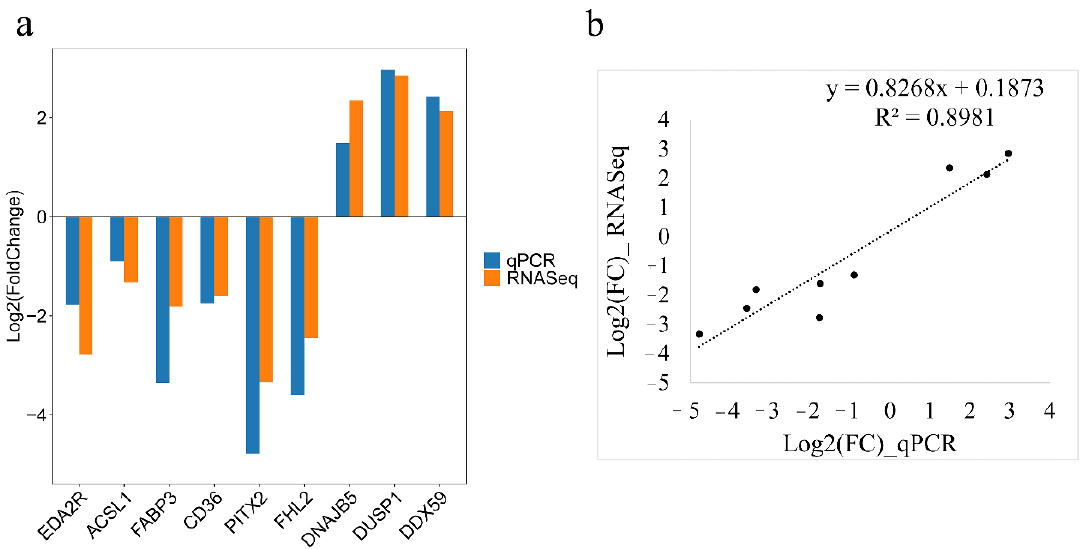
Figure 7. Validation of the RNA sequencing analysis data by quantitative real-time PCR (qRT-PCR) analysis. ( a ) The expression levels of differentially expressed genes were determined by qRT-PCR and RNA-Seq. Log 2 (FoldChange) < 0 represents down-regulated expression in line S and log 2 (FoldChange) > 0 represents up-regulated expression in line S. ( b ) The correlation analysis of gene expression between RNA-seq and qRT-PCR.